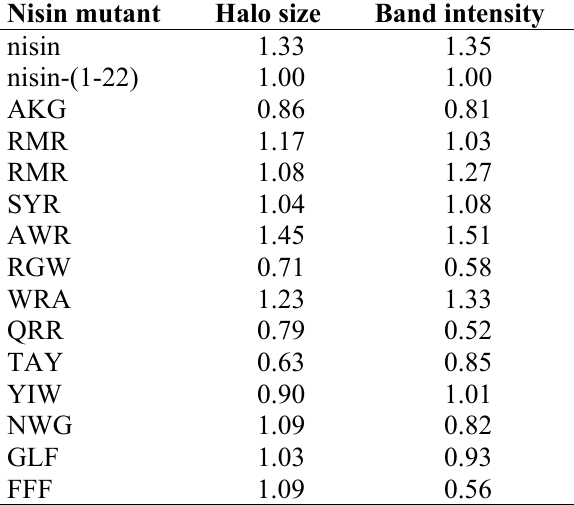
Table 3. Halo size and gel band intensity of nisin-(1-22) mutants with substituted residues in the C-terminal tail. The three amino acids correspond to residues 20, 21, and 22. Values are the average result of three independent experiments, relative to